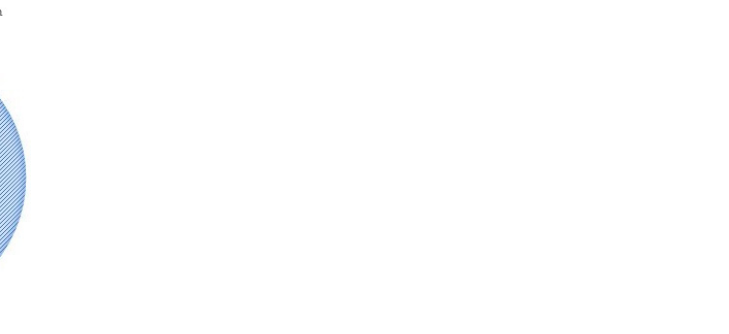
Figure 1. Prevalence of hypertension among Myanmar migrant workers in Chiang Mai, Thailand (2017). Table 2. Factors associated with hypertension among Myanmar migrant workers in Thailand.